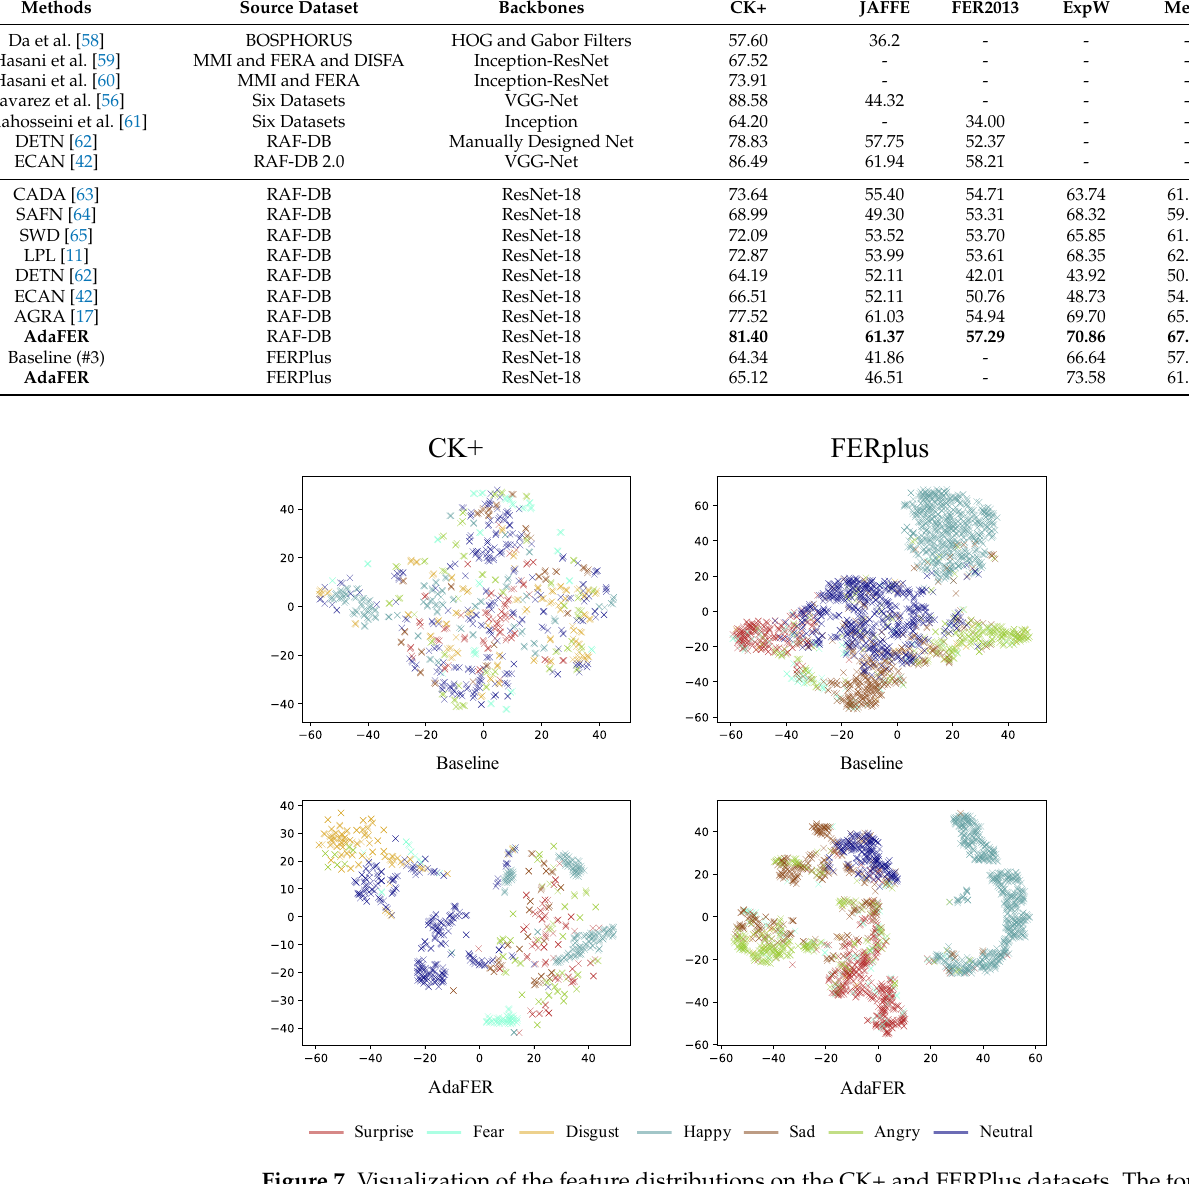
Figure 7. Visualization of the feature distributions on the CK+ and FERPlus datasets. The top and bottom parts show the feature distributions using the baseline method and AdaFER,